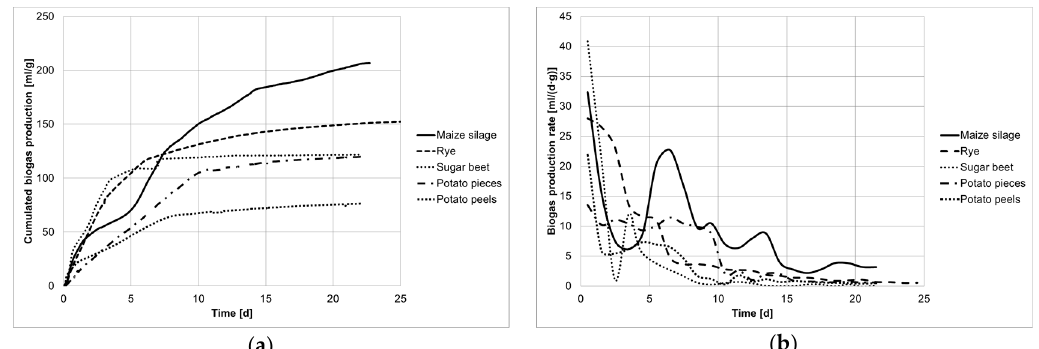
Figure 1. Biogas production within batch fermentation for different substrates (maize silage, rye, sugar beet, potato pieces and peels) ( a ) Cumulated biogas production in ml biogas per gram substrate; ( b ) Biogas production rate in ml biogas per day and gram